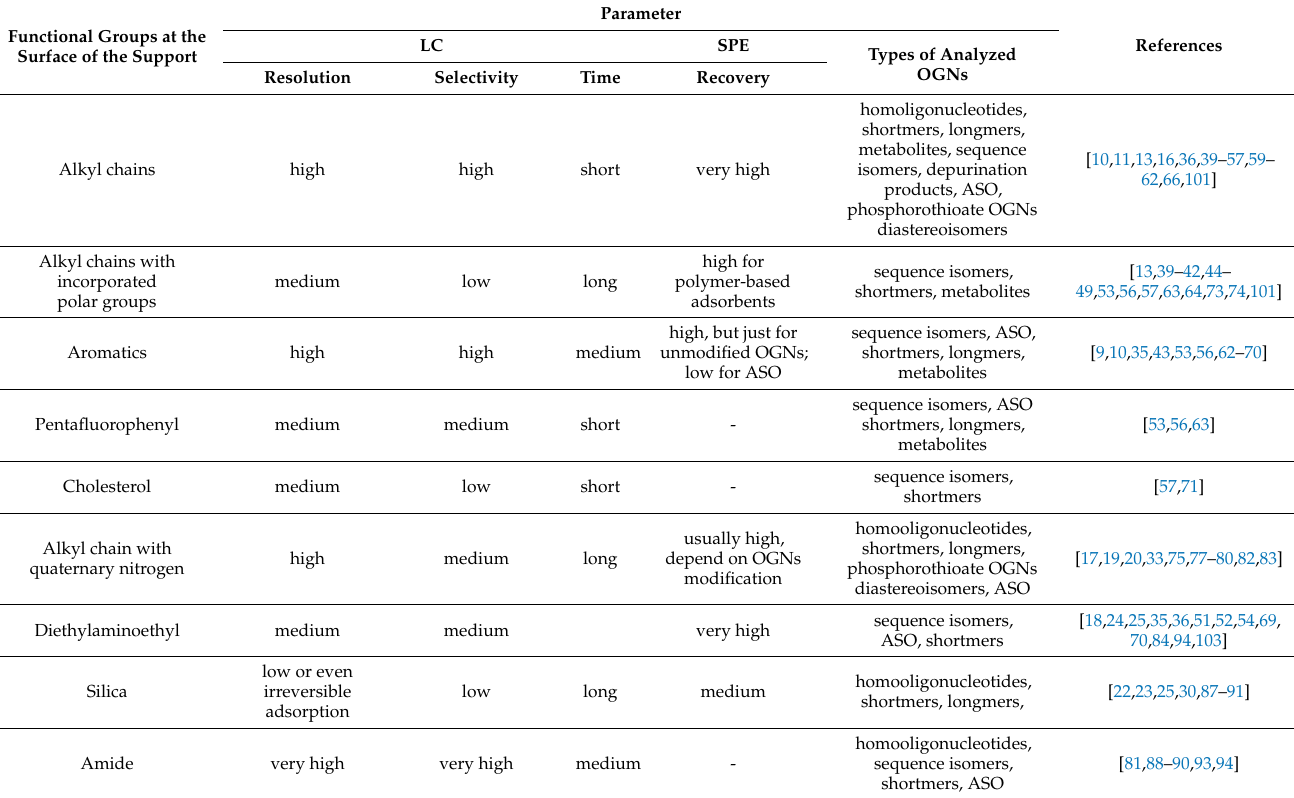
Table 1. The rough outline of functional groups impact on selected LC and SPE parameters for OGNs